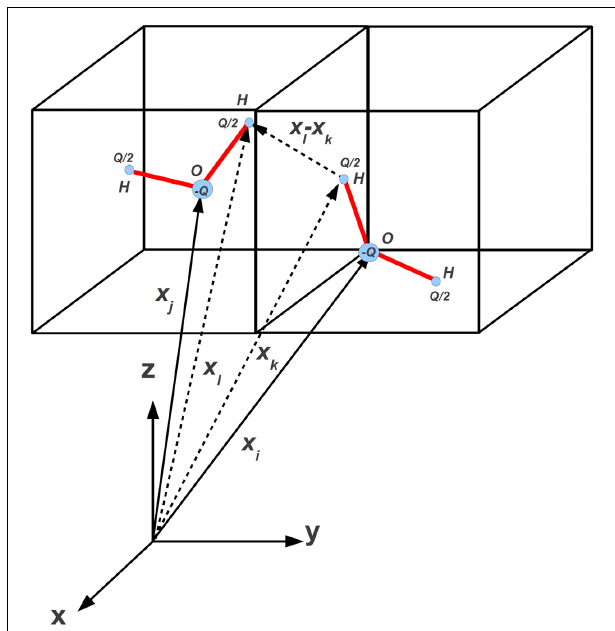
FIGURE 5 | Illustration of two water molecules sitting at lattice site x j and its neighbor x i on the D3Q27 lattice in the LTIP3P model. The center of mass of the molecules is fixed at the lattice